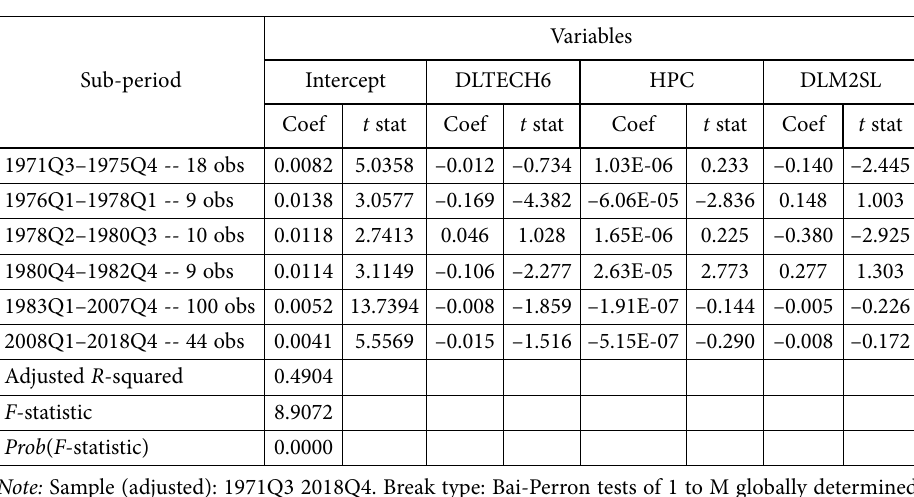
Table 6. Multivariate estimation of